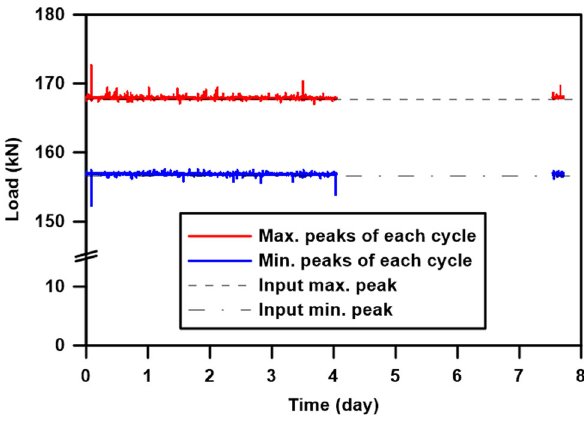
Fig. 9 Results of fatigue